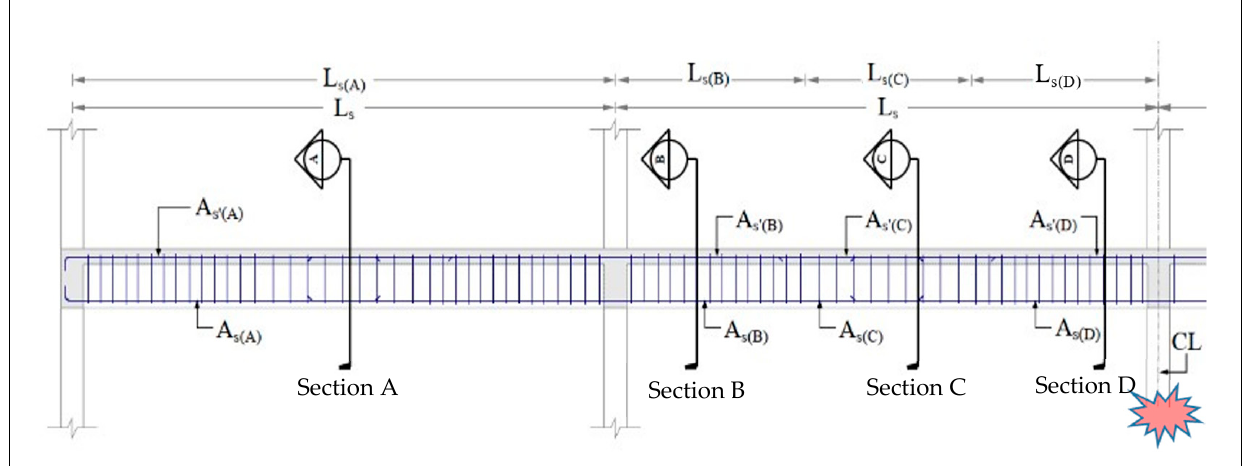
Figure 3. The sub-assemblage detailing (only half of the structure is shown due to symmetry).